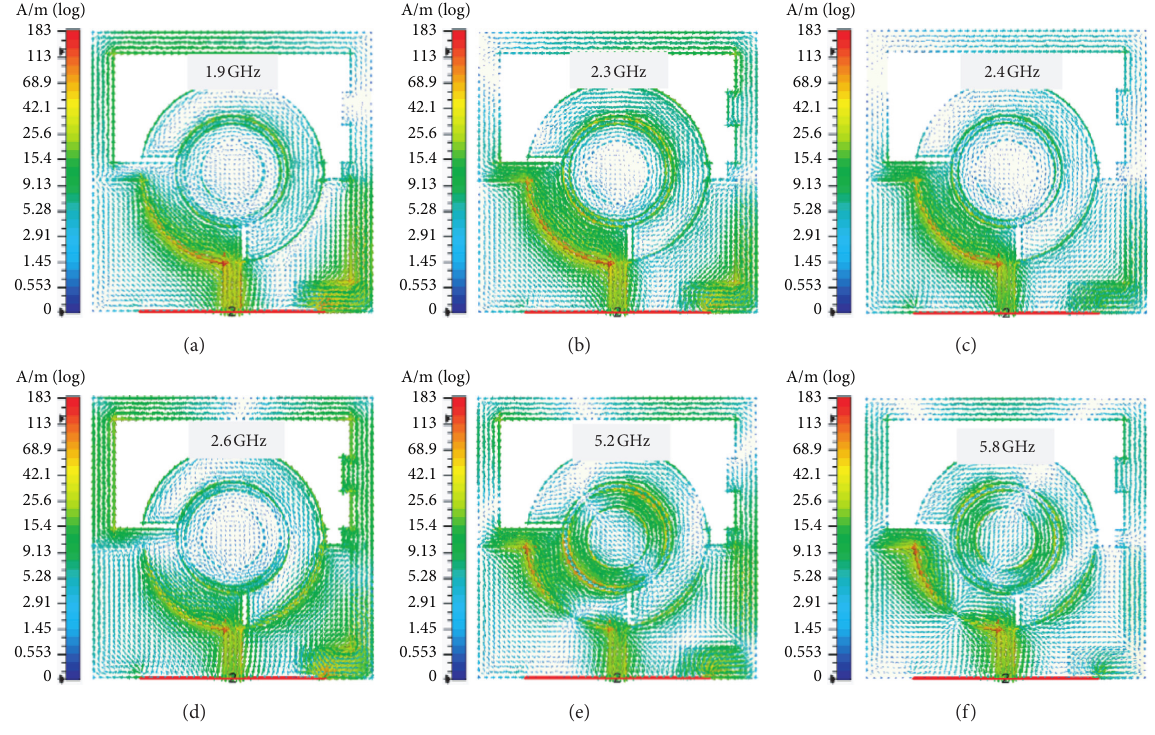
Figure 12: Current distribution of the antenna in each